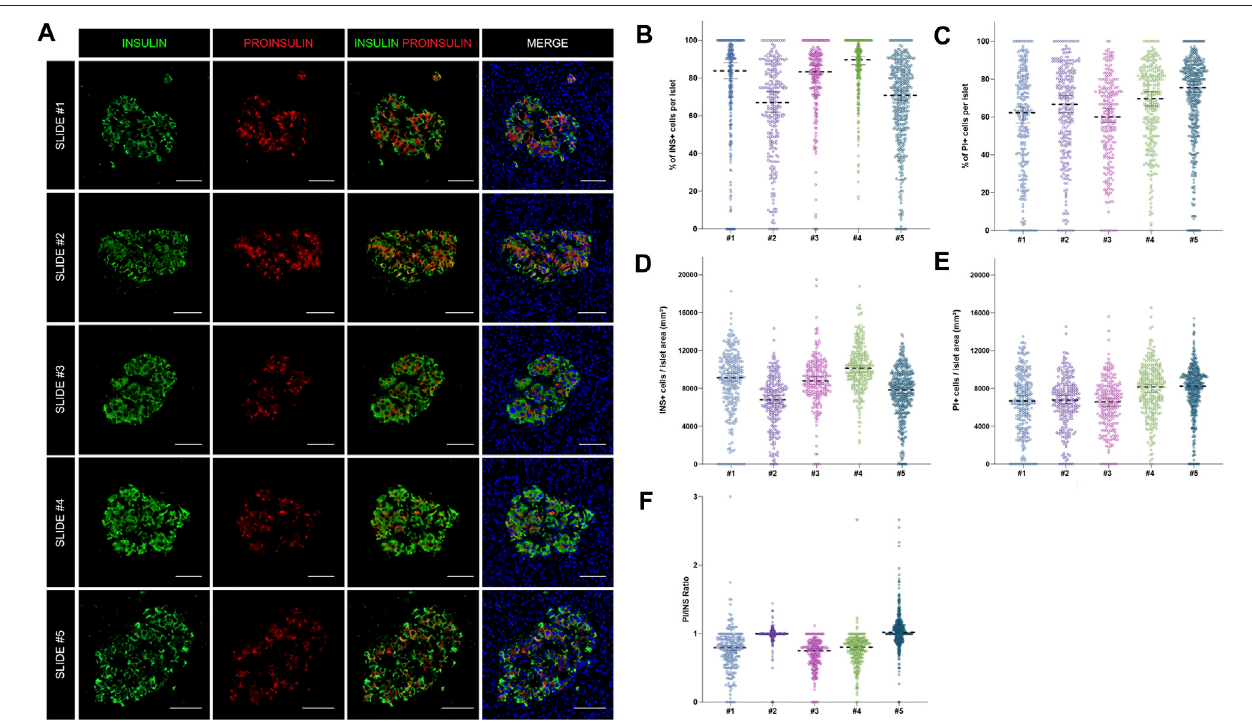
FIGURE 4 | Assessment of the reproducibility and accuracy of insulin (INS) and proinsulin (PI) positive cell detection. (A) Representative images showing insulin (INS) and proinsulin (PI) staining in islets from different pancreatic sections stained with different antibody combinations (slides #1 – 5). (B) Dot plots showing the proportion of insulin and (C) proinsulin positive cells per islet in slides #1 – 5. Each dot represents an islet. (D) Dot plots showing the density of insulin and (E) proinsulin positive cells expressed as number of positive cells per islet area in mm 2 . Each dot represents an islet. (F) Comparison of the proinsulin to insulin ratio (PI/INS) among the different samples. Each dot represents an islet. Scale bar: 50 μ